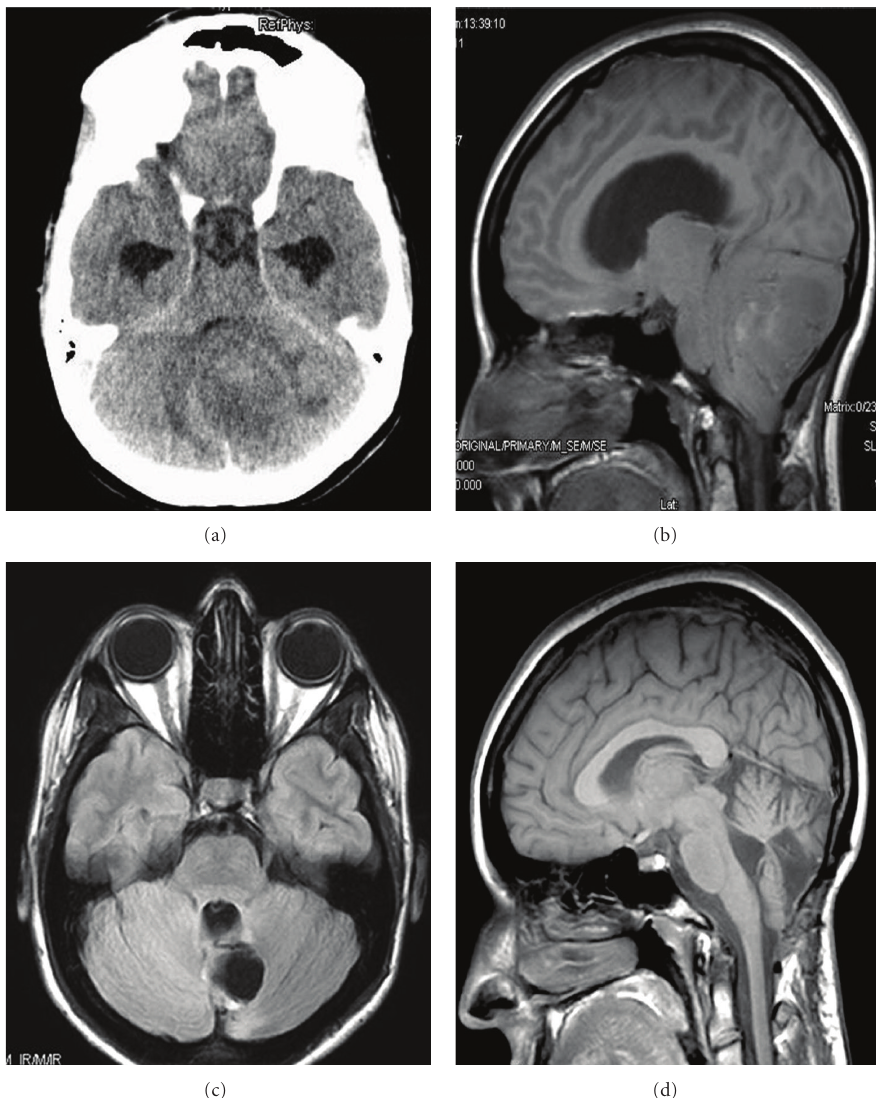
Figure 1: (a) CT-scan, after contrast administration, showing the cerebellar tumor, with peritumoral edema and hydrocephalus. (b) T1- weighted MRI, after gadolinium administration, showing the hypointense cerebellar tumor, with areas of hyperintensity. (c) and (d) T1- weighted MRI, after contrast administration, two years after surgery. Absence of residual tumor or tumor recidive can be